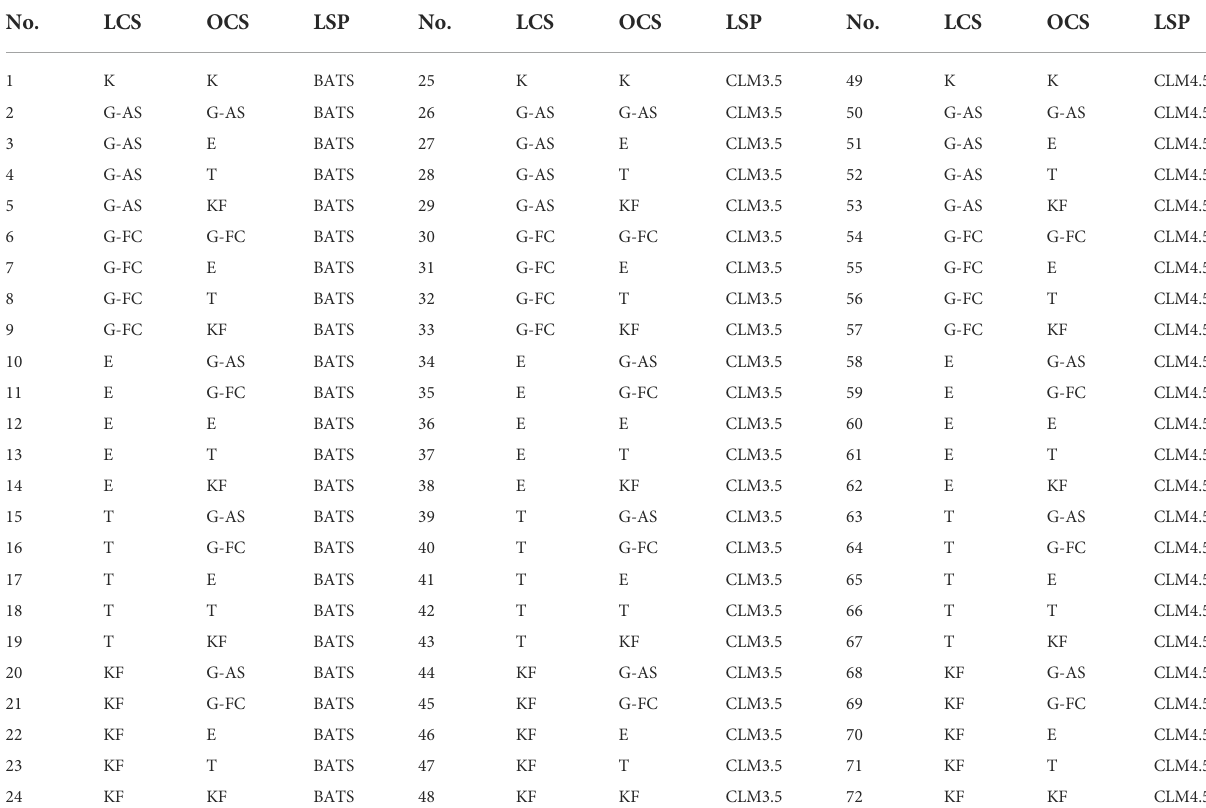
TABLE 2 Physical parameterization schemes used in the study.